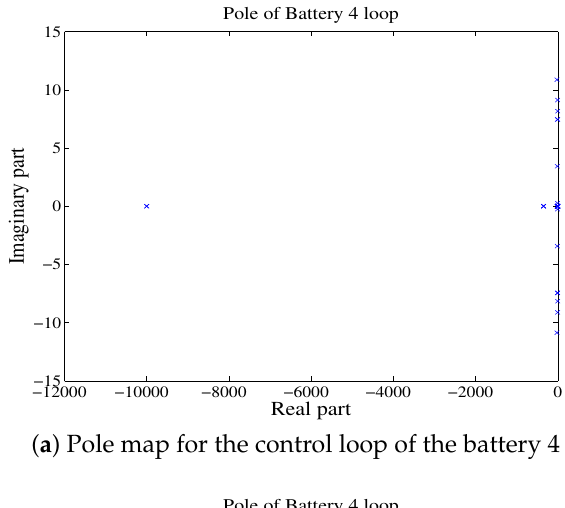
( a ) Pole map for the control loop of the battery 4